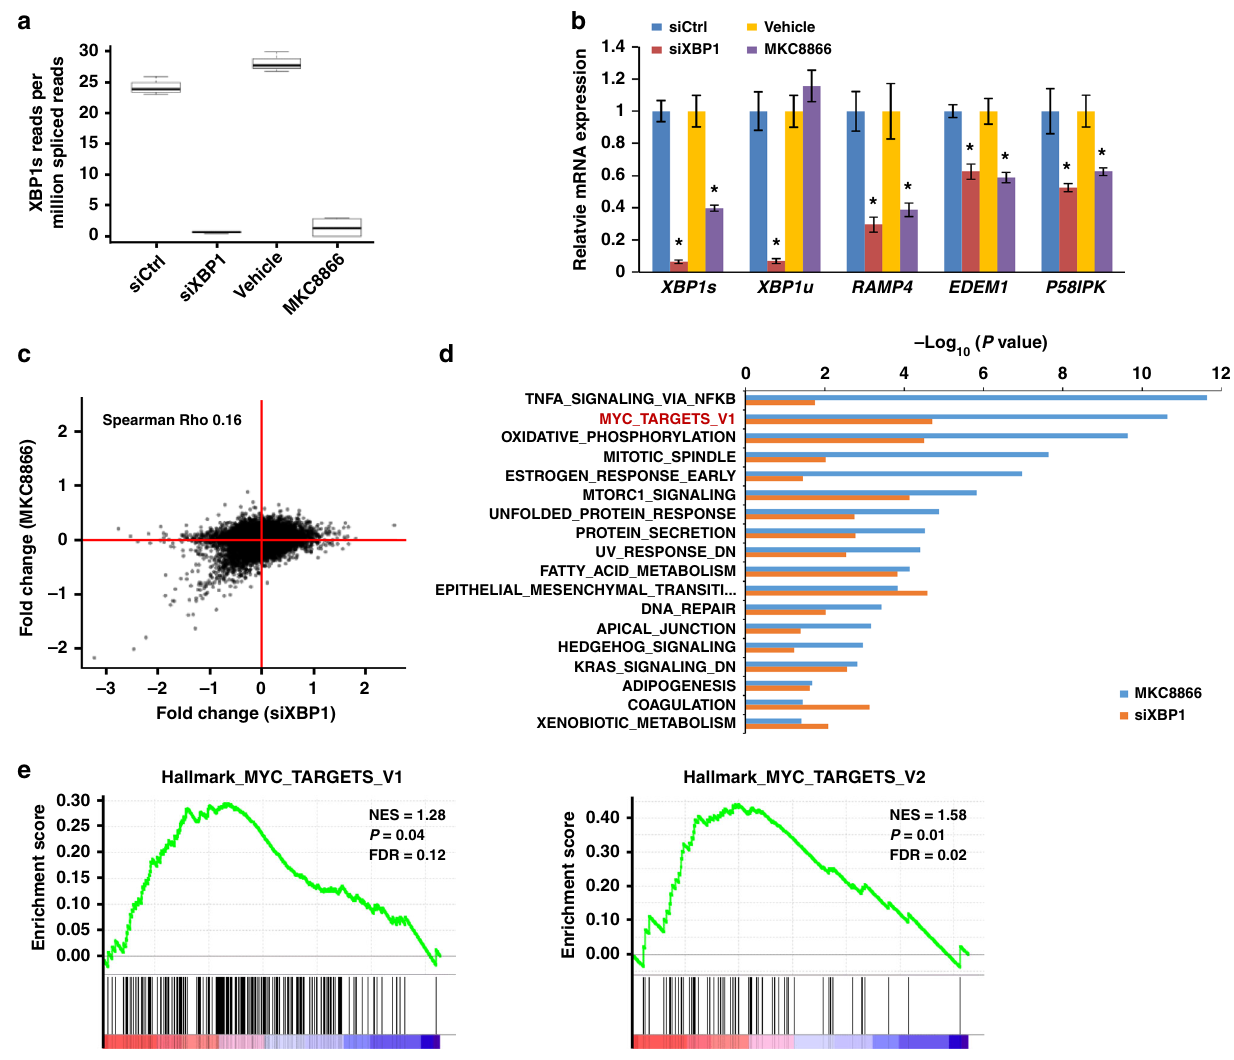
Fig. 3 IRE1/XBP1s pathway is required for multiple hallmark pathways in PCa. LNCaP cells were either left untreated or subjected to siRNA-mediated XBP1 knockdown. In parallel, cells were either treated with vehicle or MKC8866. Total RNA was isolated and used in NextGen sequencing. a The presence of the XBP1s junction is measured in the spliced RNA-seq reads and represented as a ratio of total spliced reads. The box represents the interquartile range, the horizontal line in box is the median, and the whiskers represent 1.5 times interquartile range. b The expression levels of XBP1s, XBP1u, and three XBP1s target genes were determined by qPCR. * P < 0.05, Student t -test, error bars denote SD. c Scatter plot representing the concordance of gene expression data obtained upon XBP1 knockdown and MKC8866 treatment. d Hallmark pathways enriched under both MKC8866-treated and XBP1 knockdown cells. Graph displays category scores as − log 10 ( P value) from Fisher ’ s exact test. e Hallmark pathways MYC TARGETS V1 and V2 both enriched by GSEA on combined data of siXBP1 and MKC8866